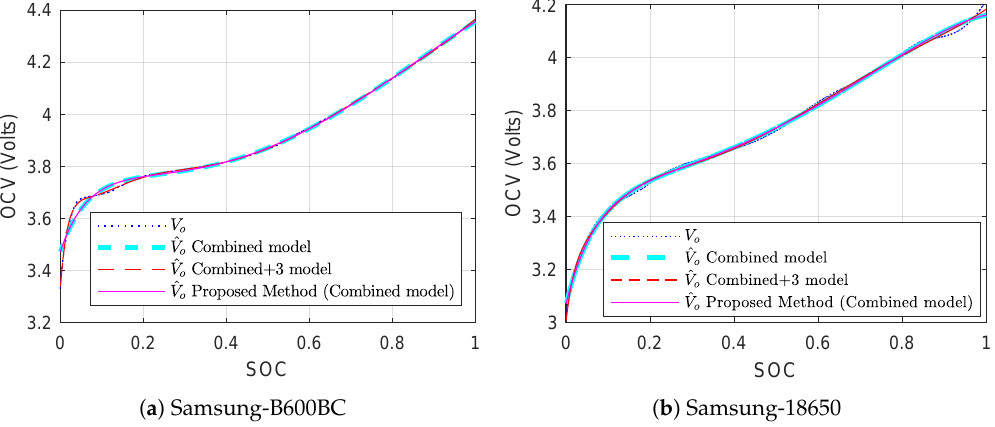
Figure 9. SOC vs. OCV estimation in ECM.